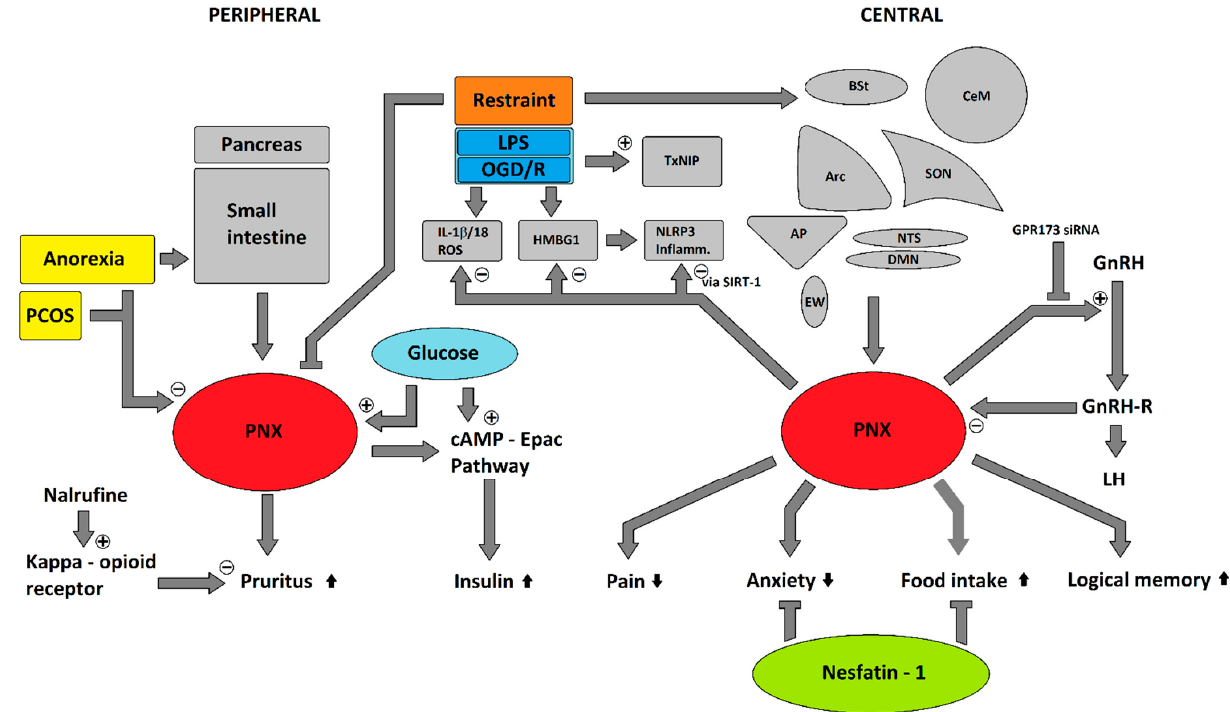
Figure 1. Phoenixin’s pleiotropic effects and interaction with nesfatin-1. Phoenixin influences various physiological processes such as metabolism, stress, hunger/appetite as well as the expression/serum levels of various chemokines/peptides. “+” or pointed arrowheads indicate an increase/augmentation of the targeted structure, “ − “ or squared arrowheads indicate a decrease/inhibition of the targeted structure.